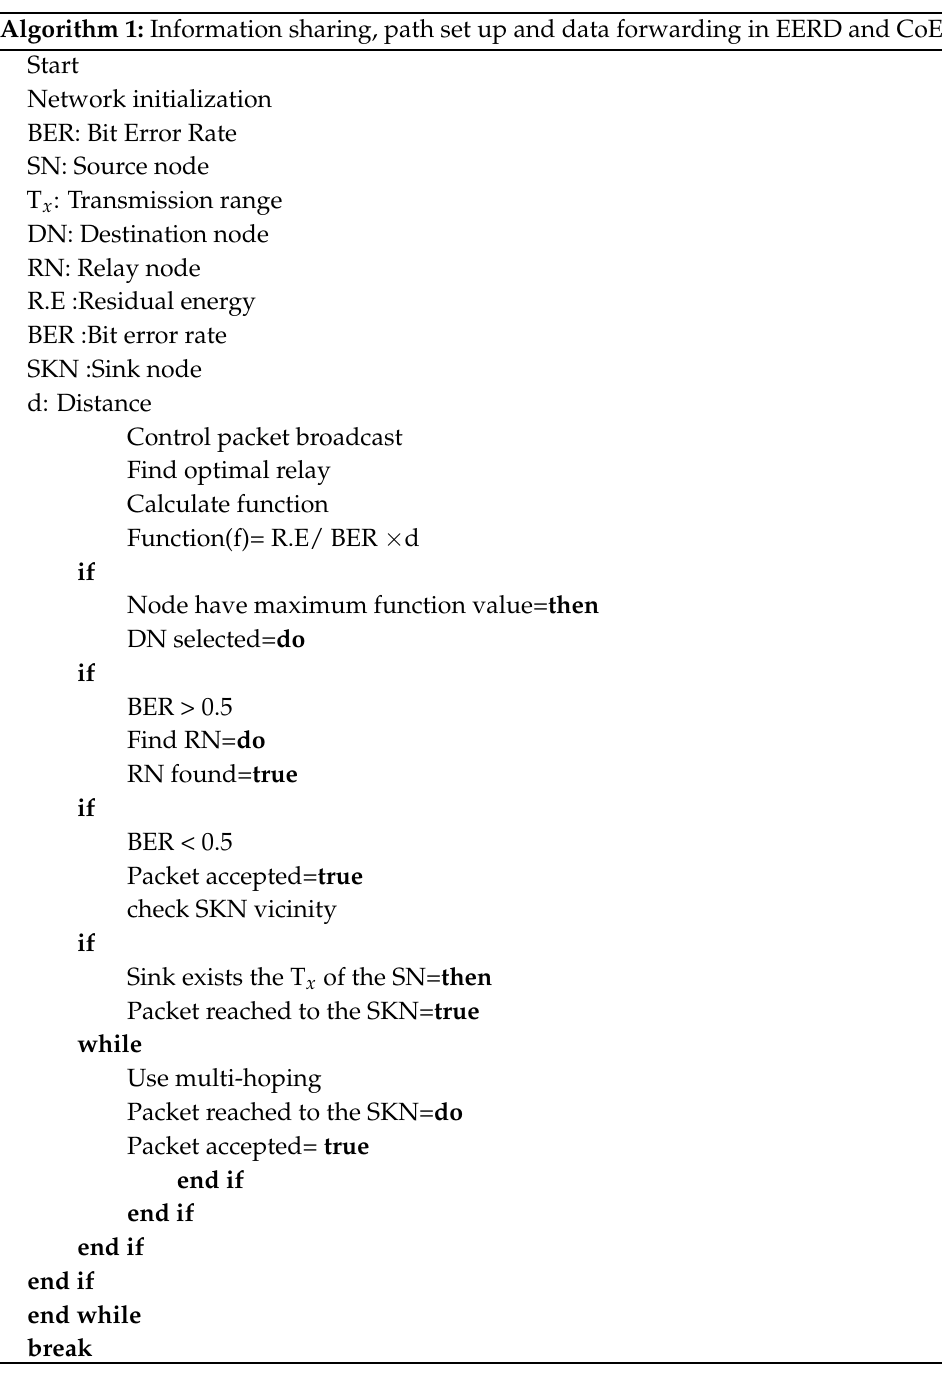
Algorithm 1: Information sharing, path set up and data forwarding in EERD and